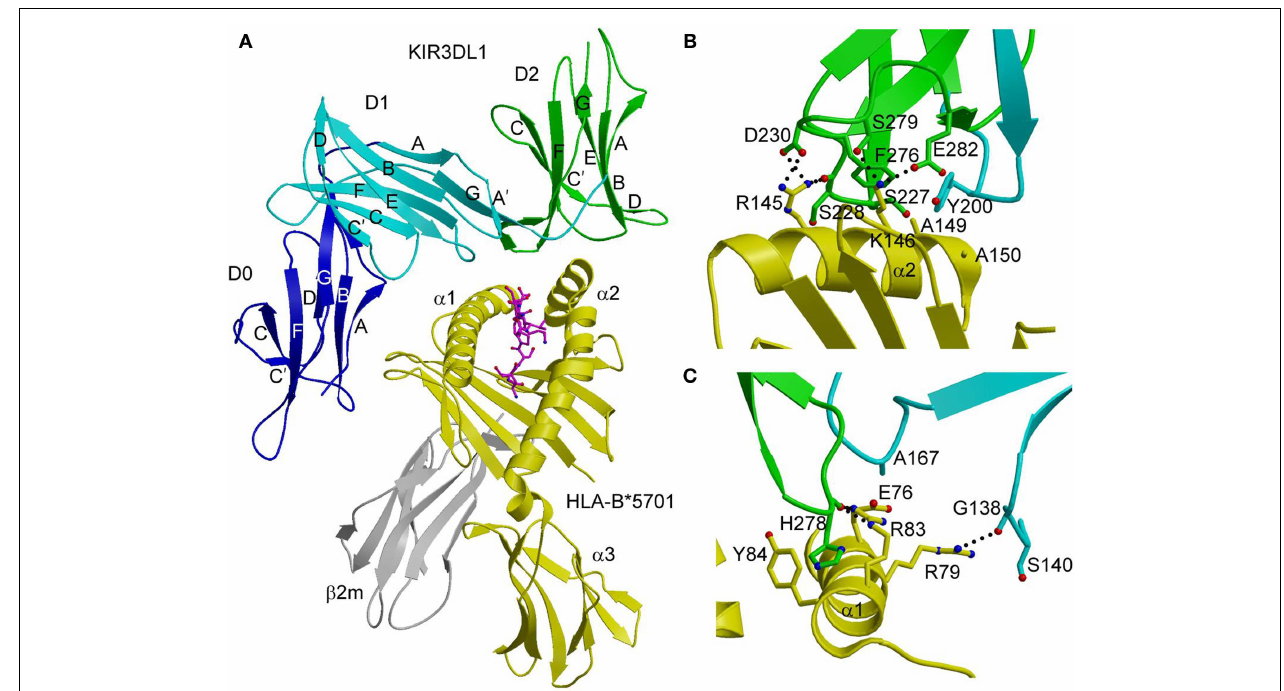
FIGURE 2 | Structure of the KIR3DL1–HLA-B*5701 complex . (A) Ribbon diagram of KIR3DL1 bound to HLA-B*5701 (3VH8).The orientation of the MHC-I ligand is similar to that of HLA-Cw3 in the KIR2DL2–HLA-Cw3 complex ( Figure 1B ).The HLA-B*5701 heavy chain is yellow; β 2 m is gray; the peptide is magenta.The KIR3DL1 D0 domain is dark blue; D1 is cyan; D2 is green.The secondary structural elements of KIR3DL1 are labeled. (B) Contacts between KIR3DL1 and the HLA-B*5701 α 2 helix.The D2